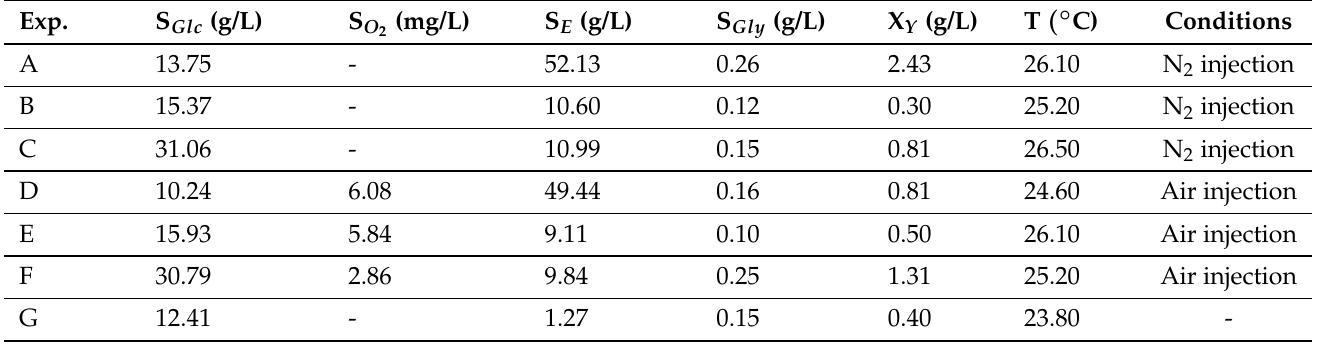
Table 2. Initial conditions of batch fermentation experiments performed under anaerobic and aero- bic